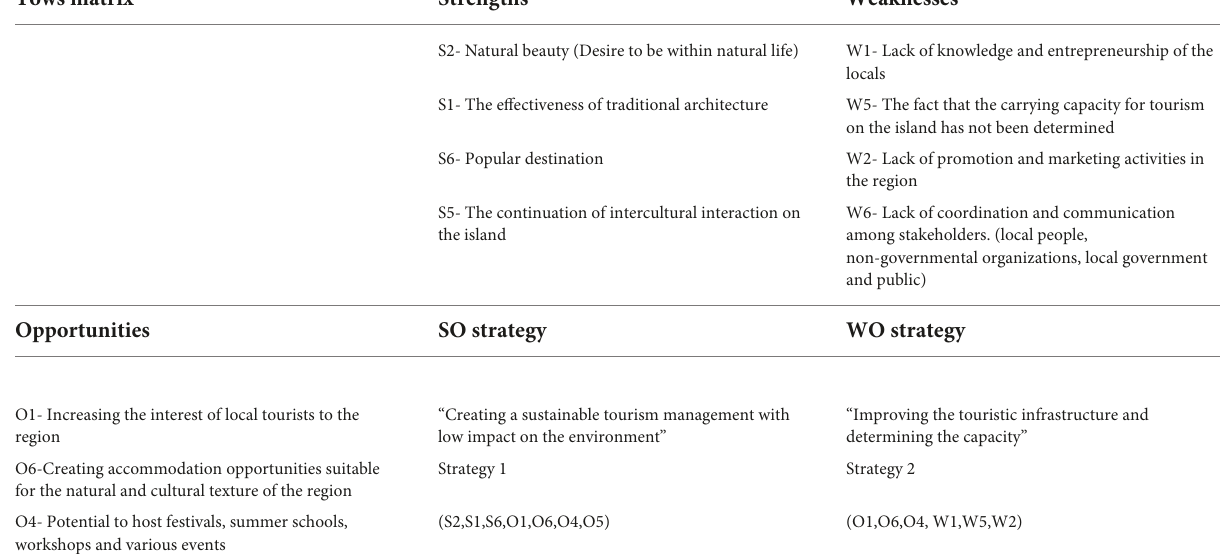
TABLE 5 TOWS Matrix for “sustainable rural tourism strategy”—produced for Gökçeada from Weihrich (1982). Tows